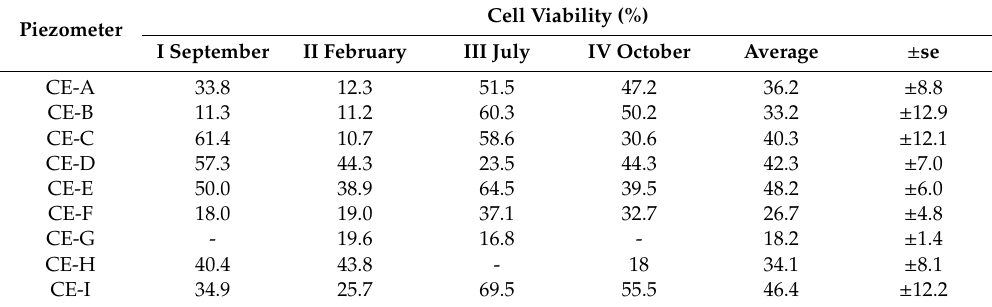
Table 8. Cell viability (% live cells / live + dead) values determined in each piezometer at each sampling